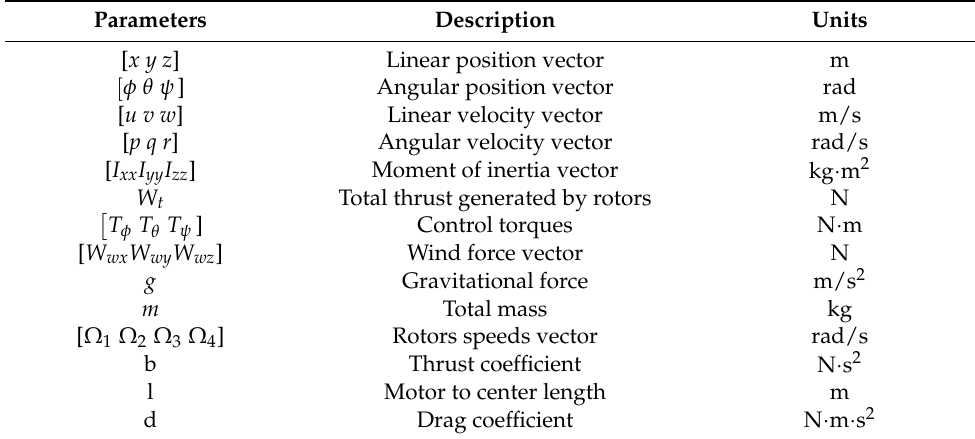
Table 2. Parameters